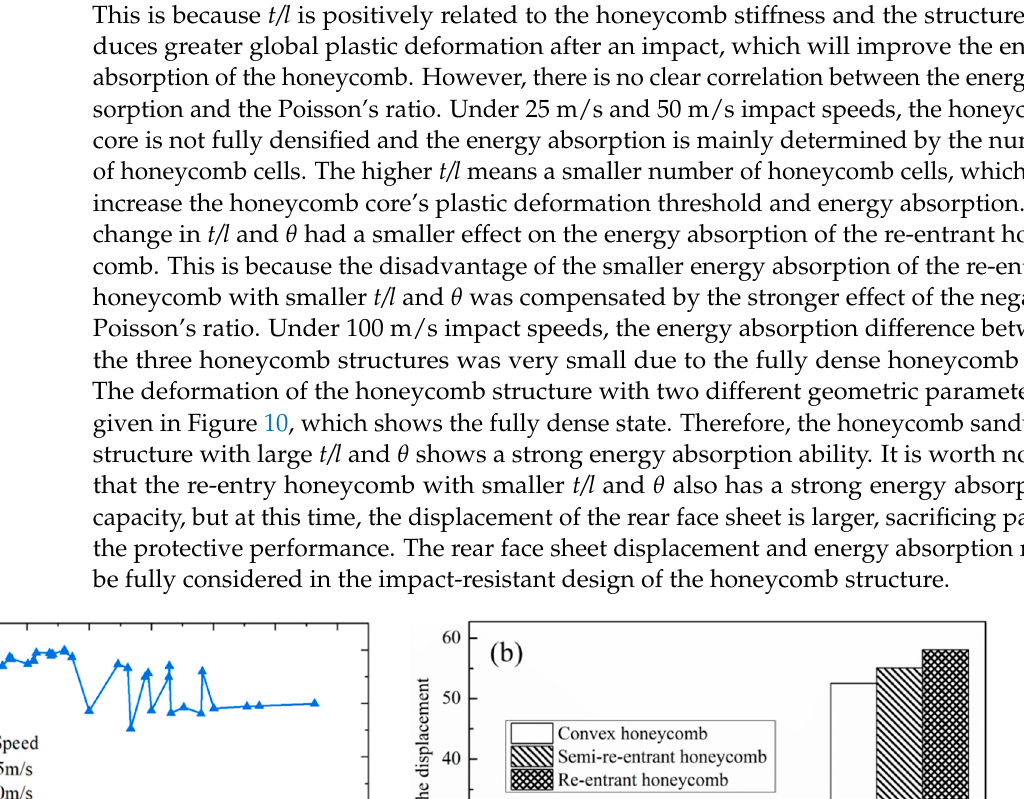
Figure 8. Energy absorption of the honeycomb structure with different Poisson’s ratios at 50 m/s impact speed: ( a ) Poisson’s ratio is positive; ( b ) Poisson’s ratio is negative; ( c ): Poisson’s ratio is zero. Figure 9. Energy absorption of the honeycomb structure with different Poisson’s ratios at 100 m/s impact speed: ( a ) Poisson’s ratio is positive; ( b ) Poisson’s ratio is negative; ( c ): Poisson’s ratio is zero.